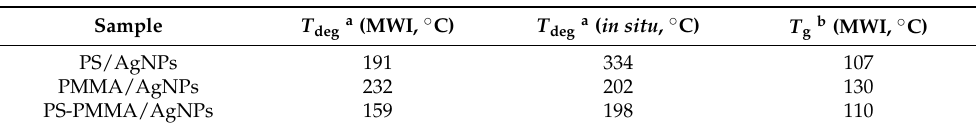
Table 1. Thermal behavior data of polymer/AgNP nanocomposites obtained from TGA and DSC measurements.